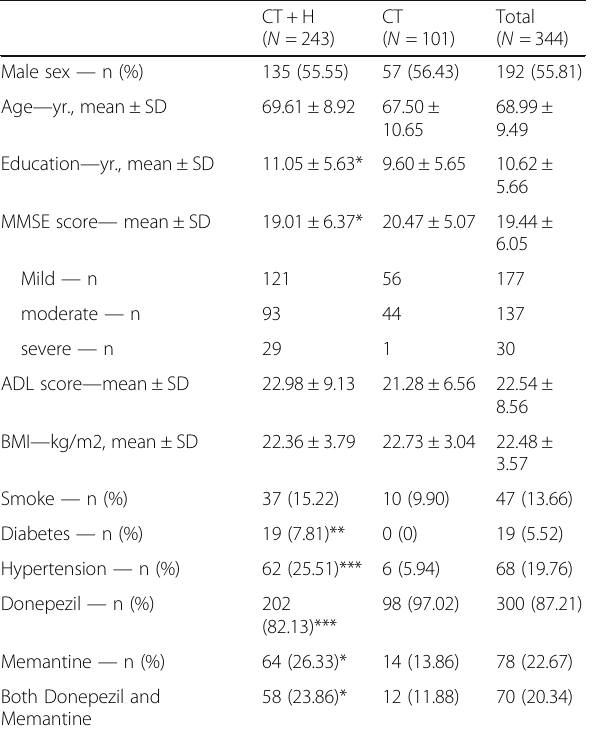
Table 1 Demographic characteristics of AD patients at baseline